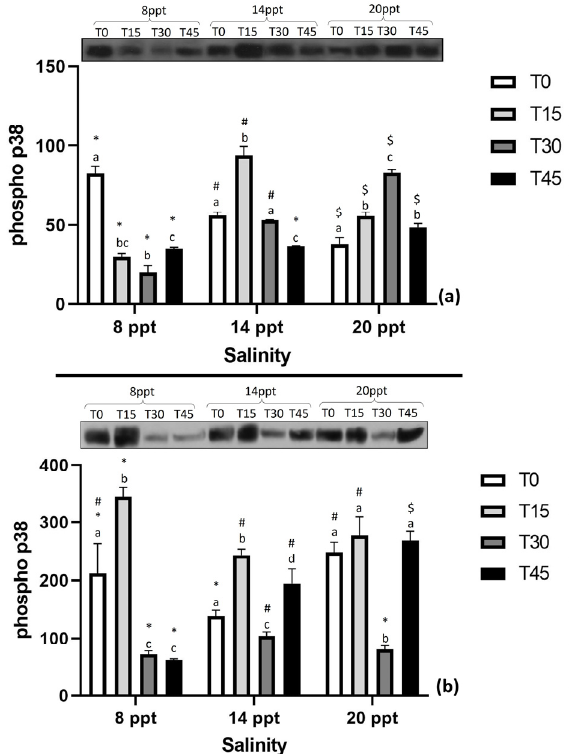
Figure 4. Phosphorylation levels of p38 MAPK in the liver ( a ) and gills ( b ) of gilthead sea bream following exposure to a salinity of 8, 14, or 20 ppt for 0, 15, 30, and 45 days. Different bar colors represent the exposure time to the experimental salinities (T0: 0 days, T15: 15 days, T30: 30 days, and T45: 45 days). Data are expressed as mean values of three replicates ± S.D. Different letters depict significant changes in phosphoryalted levels of p38 MAPK between different exposure times in each salinity, while different symbols (*, #, and $) are used to denote significant differences between the three experimental salinities at the same exposure time.